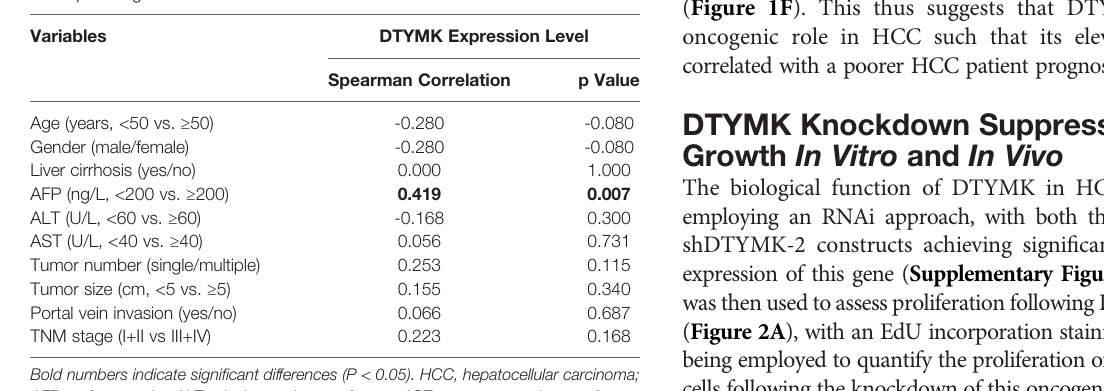
TABLE 3 | Spearman analysis of correlation between DTYMK and